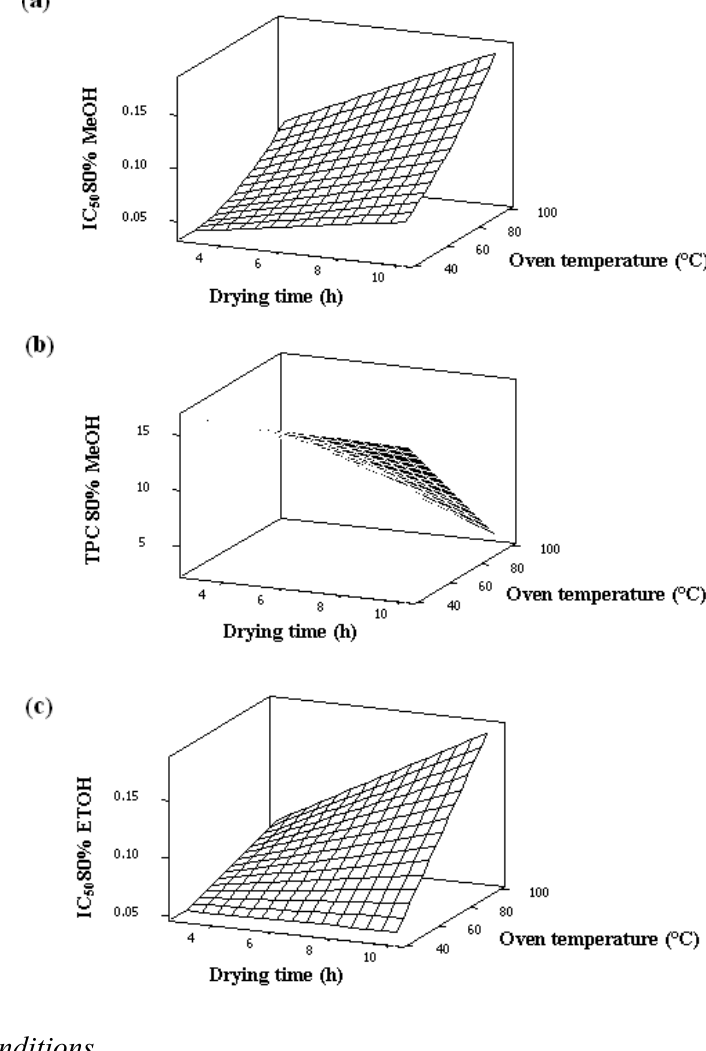
Figure 1. ( a ) Response surface plot of the influence of processing factors on IC 80% of 50 methanolic extracted sample. ( b ) Response surface plot of the influence of processing factors on TPC 80% of methanolic extracted sample. ( c ) Response surface plot of the influence of processing factors on IC 80% of ethanolic extract 50